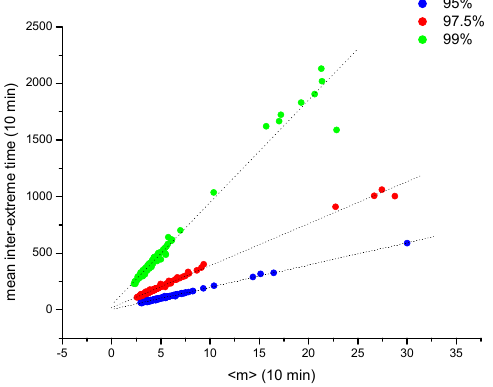
Figure 3. Relationship between the mean inter-extreme time and the mean duration < m > of wind